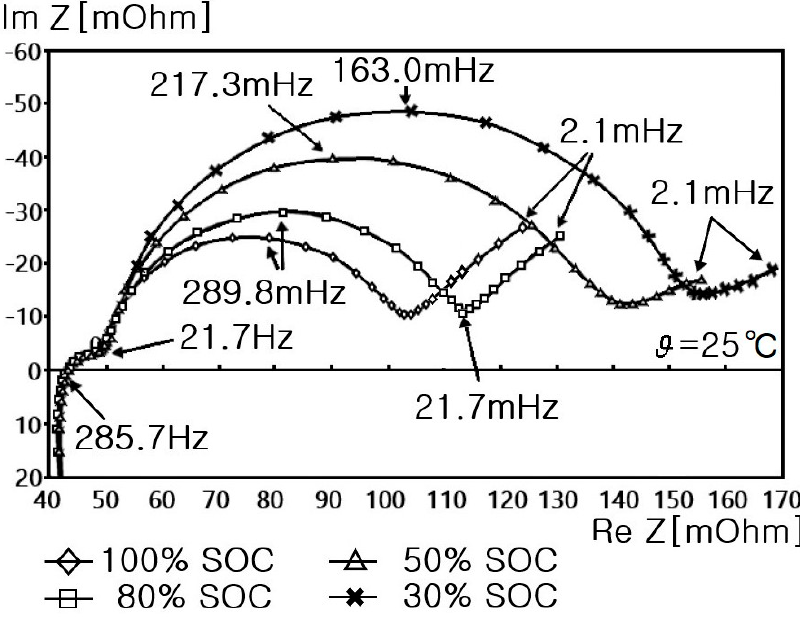
Figure 6. Impedance spectrum according to the SoC of a cylindrical Li-ion battery [5].